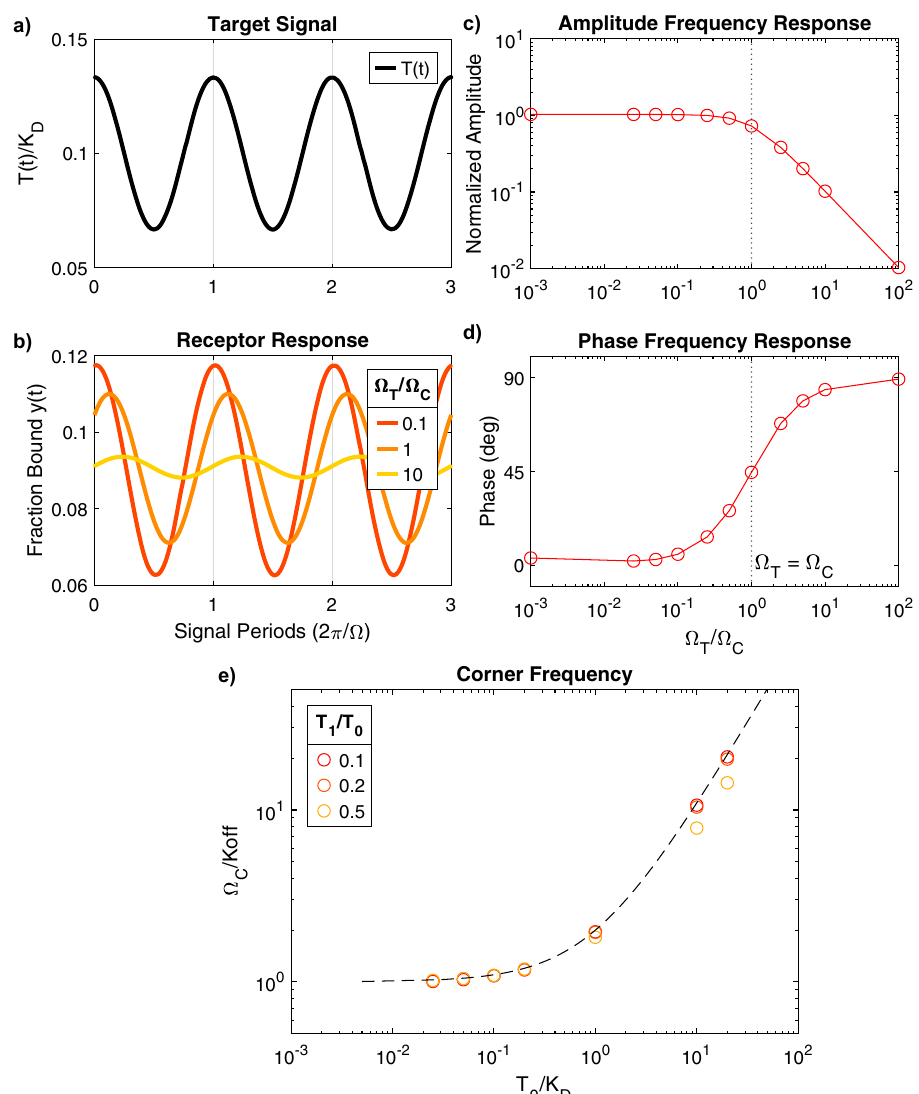
Fig. 5 | Numerical simulations of a bimolecular sensor. a Example target signal employed in a simulation with T 0 = K D =0 : 1 and T 1 = T 0 =1 = 3. Target waveforms were used as inputs to Eq. 2 to numerically simulate the response of the receptor. b Simulated steady-state responses of the receptor to the target signal in ( a ). Waveforms represent three different systems with progressively slower kinetics, where the ratio of target frequency ( Ω T ) to corner frequency ( Ω C ) increases from 0.1 (fastest kinetics) to 10 (slowest kinetics). c Amplitude and d phase measured from numerical simulations of a range of systems with progressively slower kinetics(increasing Ω T / Ω C ).Amplitudeisnormalizedtothe expectedamplitudeof